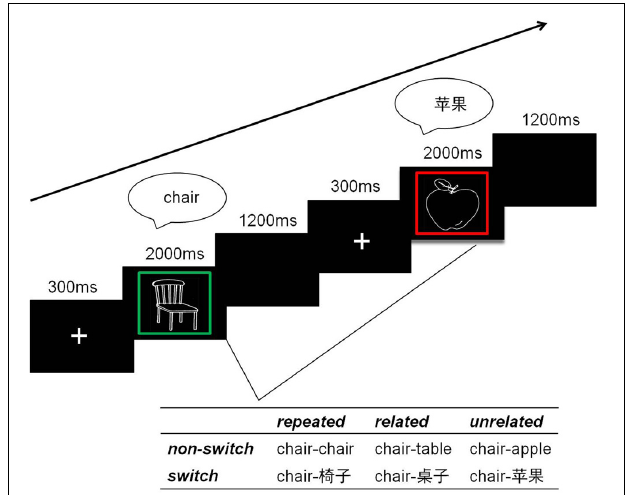
FIGURE 1 | Schematic outline of the experimental trials. In two consecutive trials, the naming language(s) was either the same (non-switch trials: e.g., English-to-English) or different (switch trials: e.g., English-to-Chinese), the concepts were either identical (repeated trials: e.g., CHAIR-to-CHAIR), semantically related (related trials: e.g., CHAIR-to-TABLE) or unrelated (unrelated trials: e.g.,